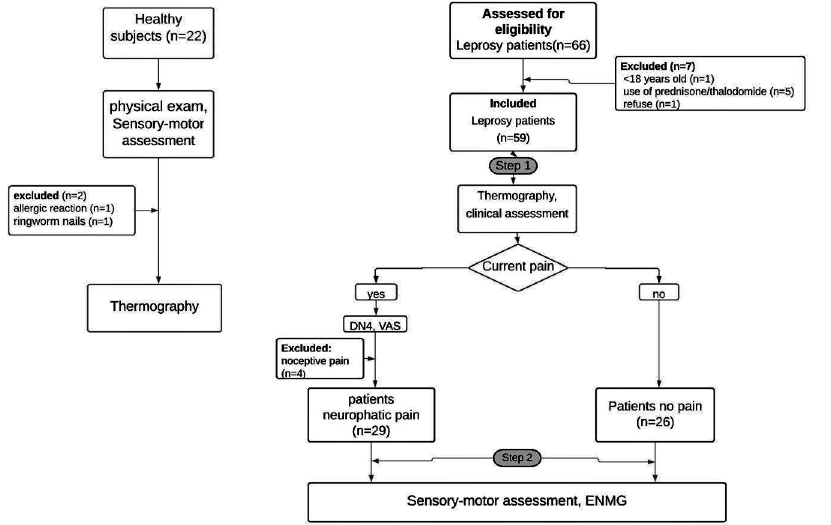
Fig 1. Flowchart of data collection and subject